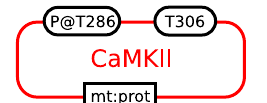
Figure 2.1: Example of an entity named CaMKII, that carries two state variables represent- ing the phosphorylated residue threonine 286 and the residue threonine 306, and a unit of information precising its material status (protein).